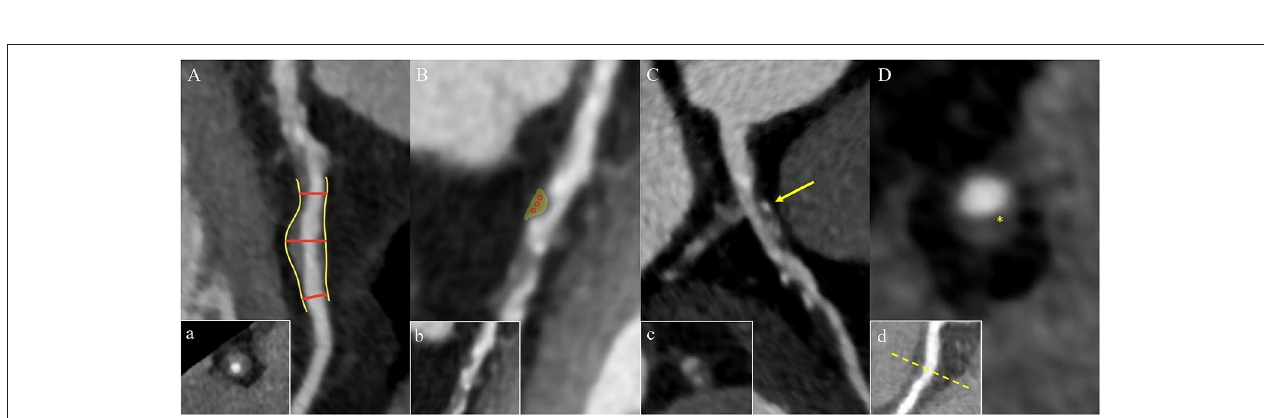
FIGURE 2 | High-risk plaque characteristics on CCTA. (A) Positive remodeling of a non-calcified plaque in the proximal left anterior descending coronary artery. The two short red lines indicate the vessel diameters of the proximal and distal of the plaque (both 1.0mm), and the long red line indicates the maximum vessel diameter in the middle of the plaque (1.6mm). The remodeling index is 1.6. Picture a is the cross section of picture (A) . (B) A low-attenuation plaque (yellow area) in the mid segment of the left anterior descending coronary artery with a mean CT attenuation value of 21 HU in the three regions of interest (red circles). Picture b is the original picture (B) . (C) Spotty calcification of a partially calcified plaque surrounded by non-calcified components in the proximal left anterior descending coronary artery with a diameter < 3mm in all directions (yellow arrow). Picture c is the cross section of picture (C) . (D) A napkin-ring sign plaque in the proximal right coronary artery. The yellow star shows the central area of the plaque with a low HU close to the lumen, which is surrounded by the peripheral edge of higher CT attenuation. Picture d is the multiplanar reconstructed image of picture (D) . CCTA, coronary computed tomography angiography; HU, Hounsfield units.